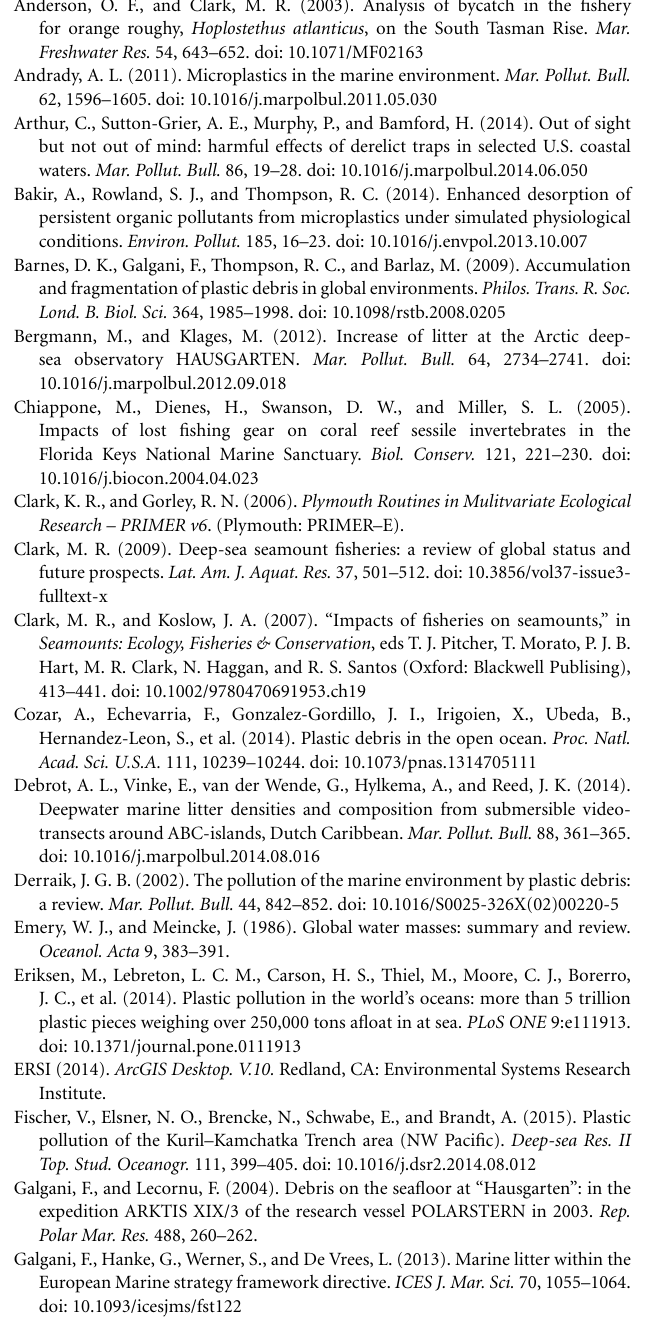
Figure S1 | Photographs of habitat categories increasing from smooth (A) to most rugose